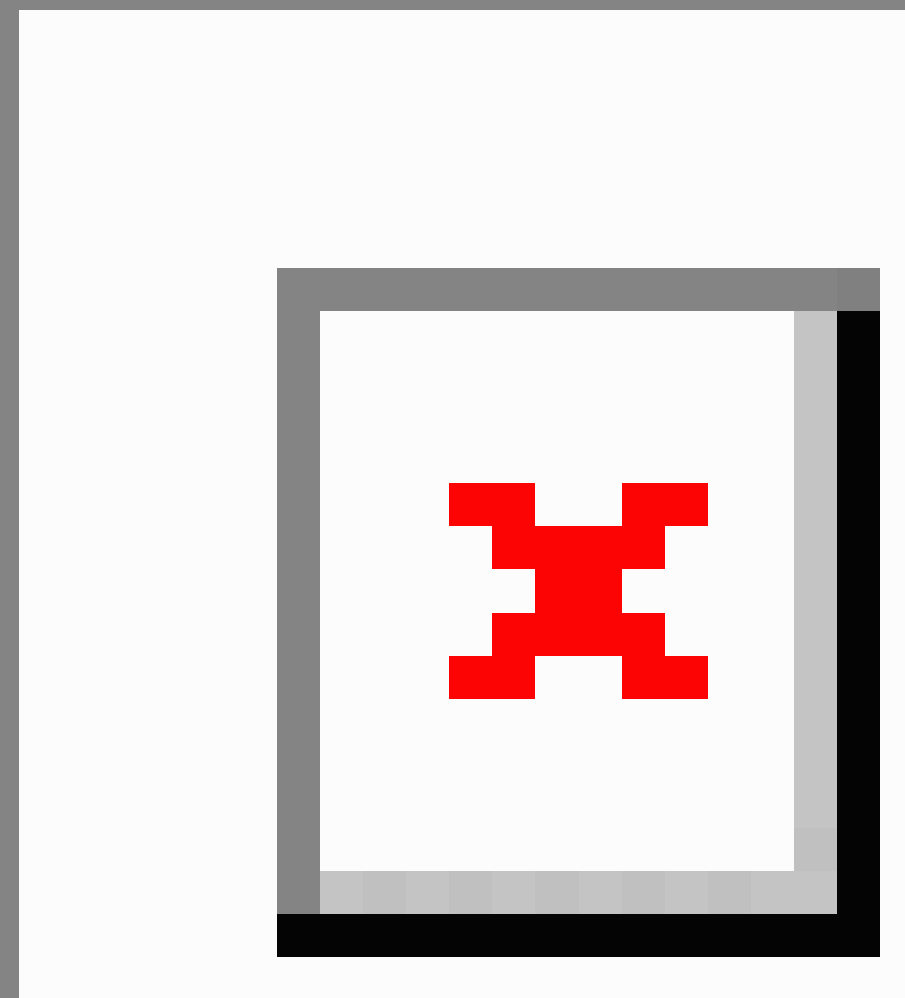
Figure 1. Screenshot of Web Coach website home